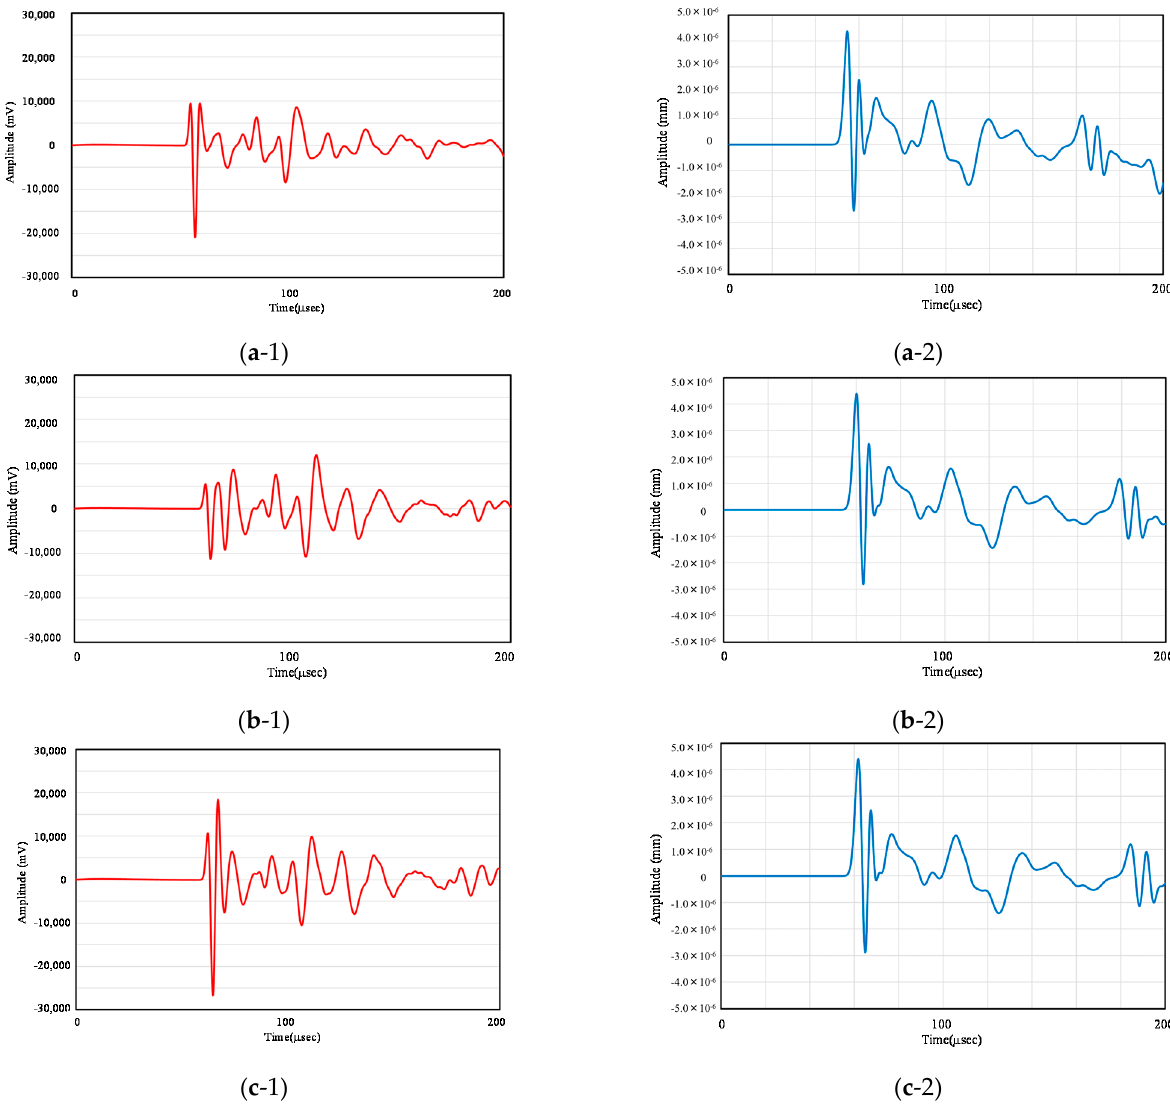
Figure 8. Measured waveform: ( a-1 ) measured waveform on date 1, ( a-2 ) Analysis result on case 1, ( b-1 ) measured waveform on date 4, ( b-2 ) Analysis result on case 4, ( c-1 ) measured waveform on date 6, ( c-2 ) Analysis result on case 6. Table 4. Parameters used in the